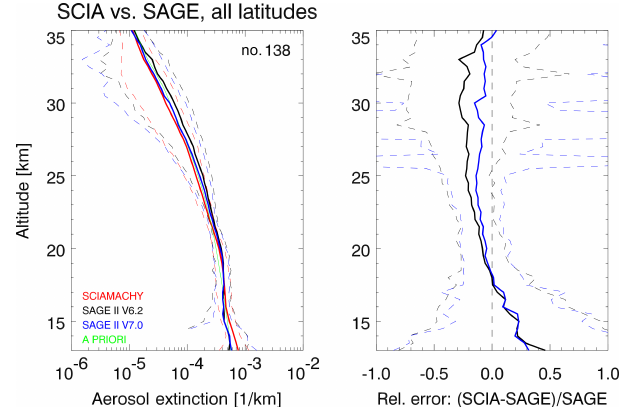
Figure 5. Left panel: comparison of average co-located SAGE II (black and blue) and SCIAMACHY (red) aerosol extinction profiles with standard deviation (dashed lines) for cloud-free SCIAMACHY limb-scatter observations only. The green line shows the a priori extinction profile used for the SCIAMACHY retrievals. The num- ber in the top right corner shows the number of co-locations aver- aged. Right panel: mean relative difference between SCIAMACHY and SAGE II aerosol extinction profiles with standard deviation